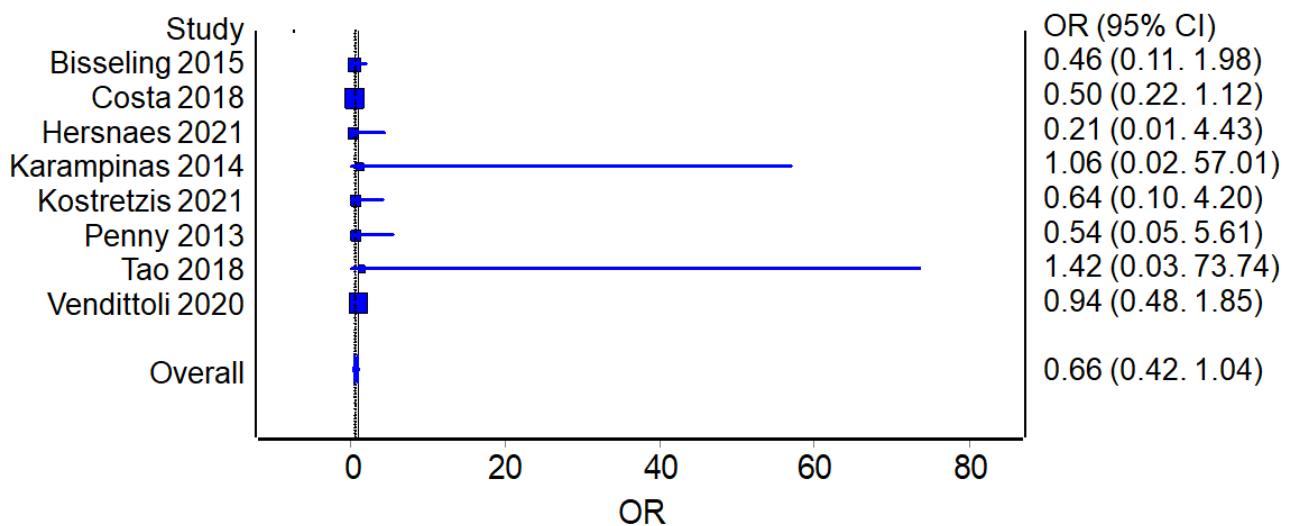
Figure 4. Complications Rates: Forest plot of the individual studies and pooled mean difference for complication rates, including a 95% confidence interval. The size of the squares shows the weight of the study [15 – 22,24 – 31].